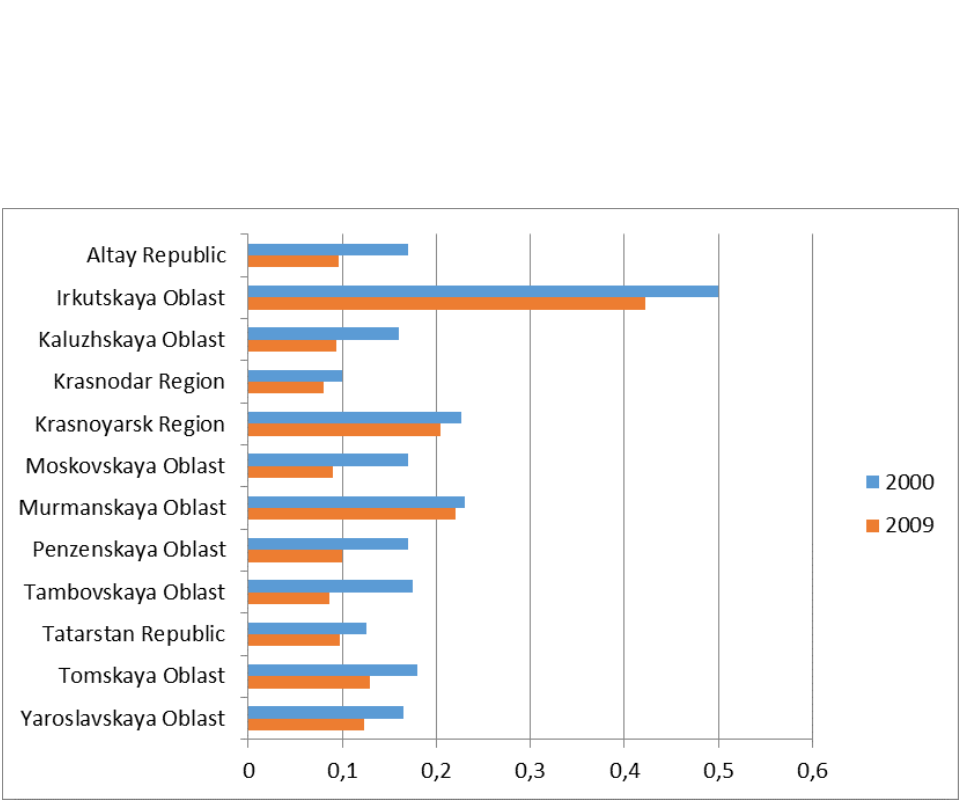
REGION : Volume 3, Number 1,